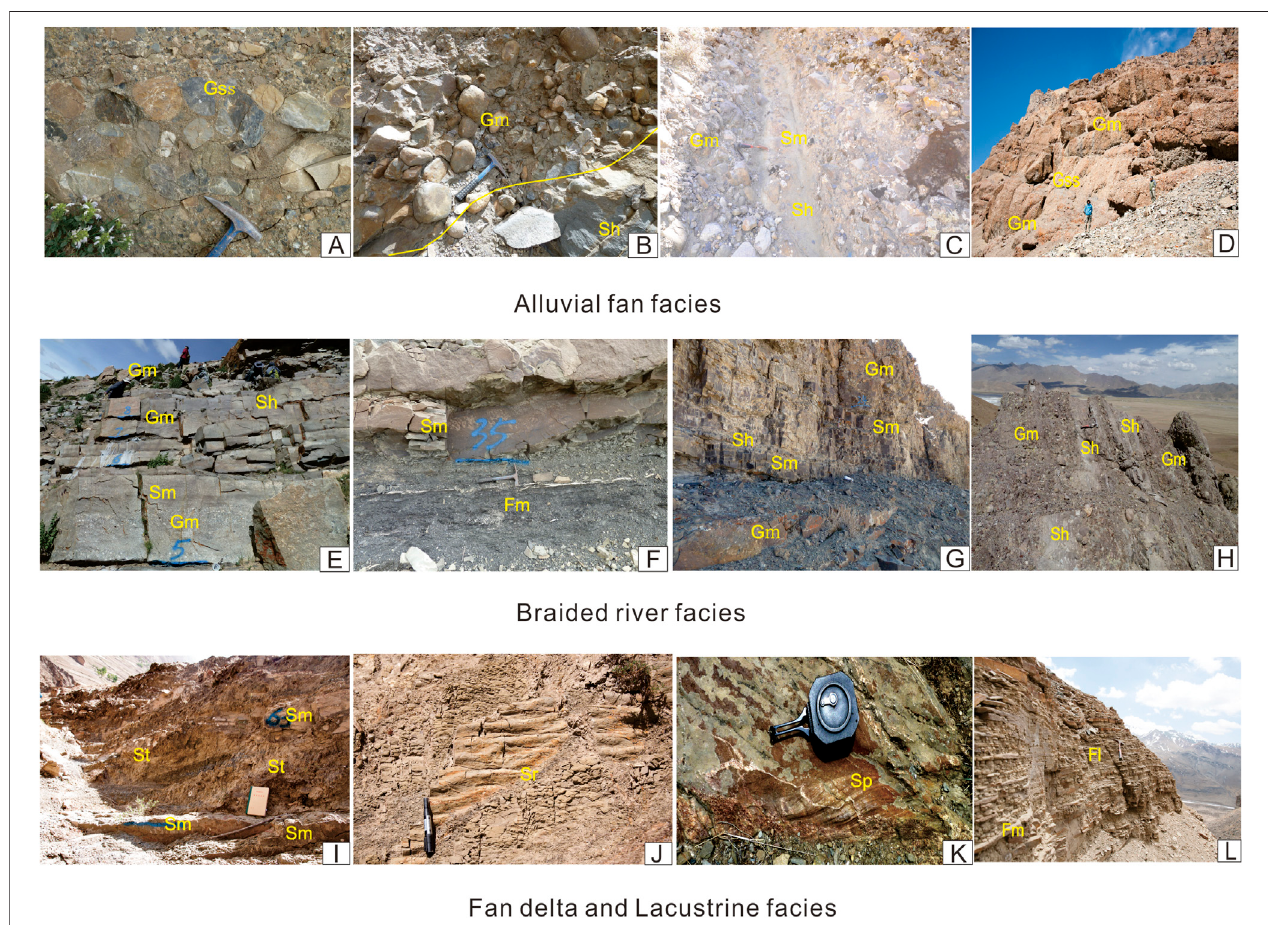
FIGURE 3 | Typical outcrops of Gangdese conglomerate in measured sections. Table 1 for lithofacies codes. (A) Lower member of section K2, Kailas locality. (B) Lower member at section K2, Kailas locality showing erosive surface. (C) Lower member of section K6, Xigaze locality. (D) Lower member of section K4, Mayoumu locality. (E) LowermemberofsectionK1,Kailaslocality. (F) Middlemember ofsectionK1,Kailaslocality. (G) Middlemember ofsectionK4,Mayoumulocality. (H) Upper memberofsectionK5,Sangsanglocality. (I) UppermemberofsectionK6,Xigazelocality. (J) UppermemberatsectionK6,Xigazelocalityshowingripplemark. (K) Upper member at section K6, Xigaze locality showing planar cross-bedding. (L) Lower member of section K3, Kailas locality.